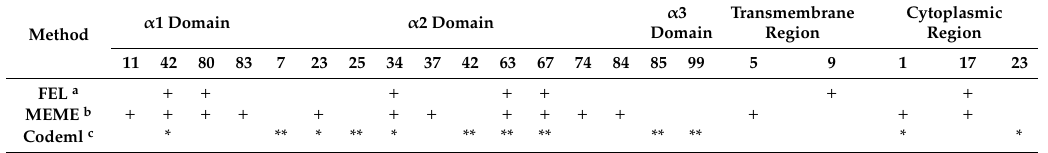
Table4. Summarystatisticsforcodonsitesundergoingpositiveselectionidentifiedbydi ff